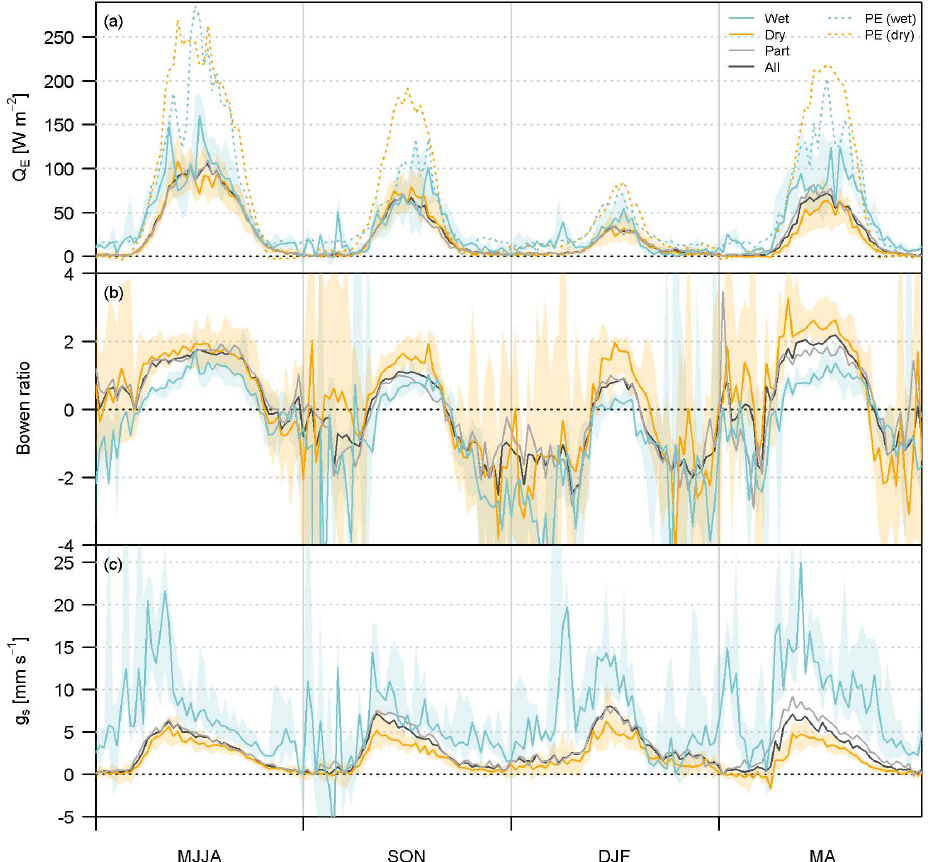
Fig. 11. Median diurnal cycles and interquartile ranges (shading) of (a) measured and potential evaporation (PE), (b) Bowen ratio and (c) surface conductance by season and for different surface conditions: wet (1 to 6h after rain), partially wet (6h to 2 days after rain) and dry ( ≥ 2 days since